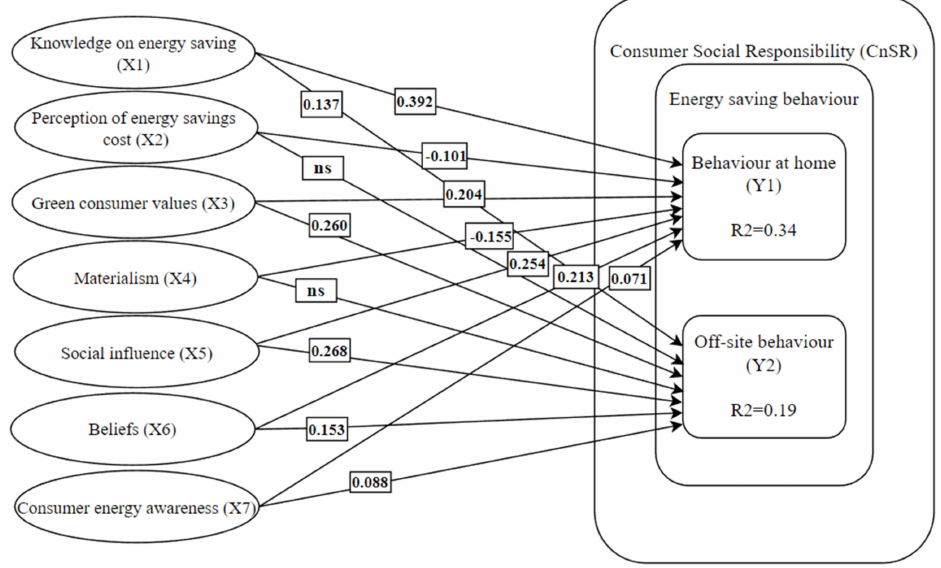
Figure 2. Results of structural model estimation.